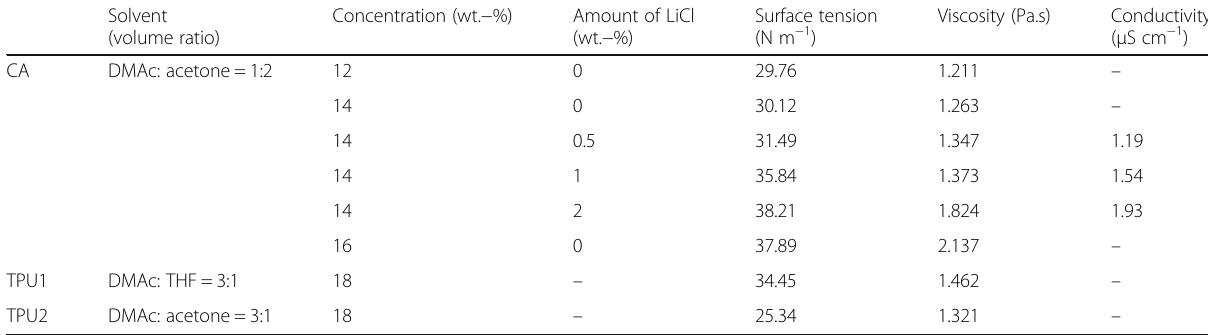
Table 1 Properties of different electrospinning